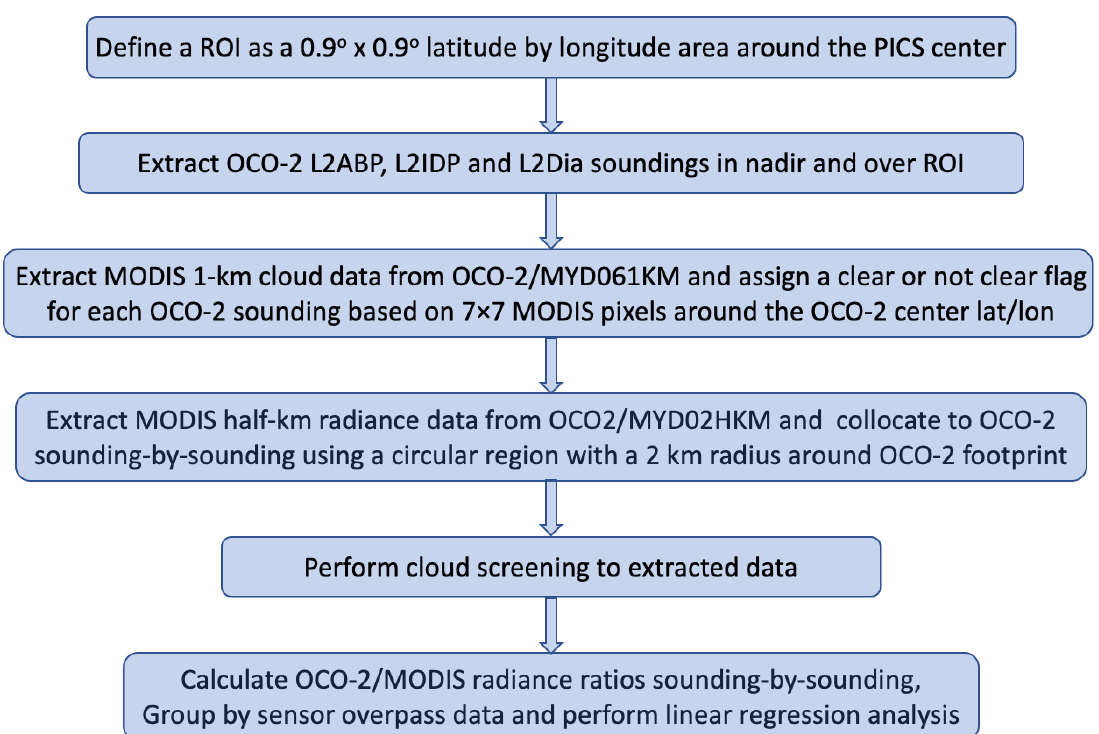
Figure 3. Schematic flow diagram for for OCO-2 and MODIS inter-comparision data processing for each of the eight